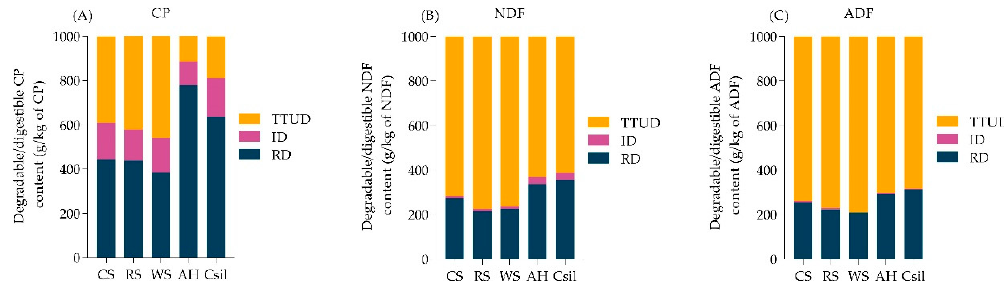
Figure 2. Ruminal degradable content, intestinal digestible content, and total-tract undigested content of CP, and NDF, and ADF in different forages. ( A ) CP, ( B ) NDF, and ( C ) ADF. RD, ruminal degradable content was determined after ruminal incubation for 12 h (CP) and 24 h (NDF and ADF); ID, intestinal digestible content; TTUD, total-tract undigested content. CS, corn straw; RS, rice straw; WS, wheat straw; AH, alfalfa hay; Csil, corn silage; DM, dry matter; CP, crude protein; NDF, neutral detergent fiber; ADF, acid detergent fiber. Each forage was incubated in 6 replicates (two for each time point per cow) in the rumen and 12 replicates for intestinal incubation.